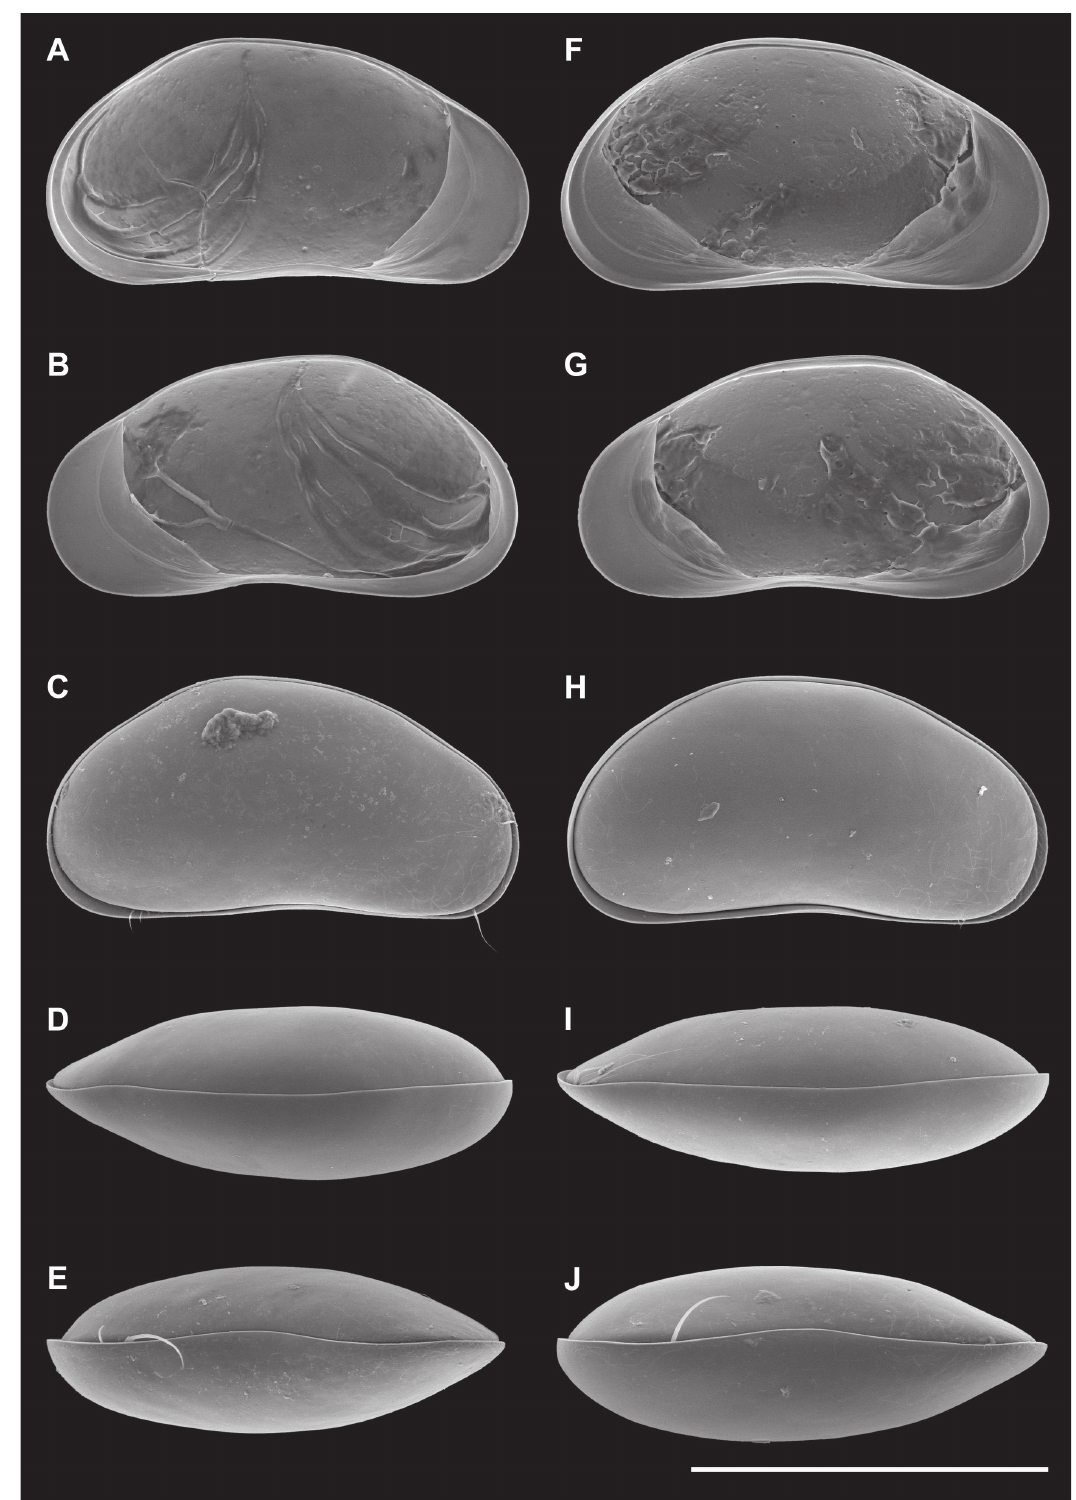
Fig. 2. Valves of Pseudocandona agostinhoi sp. nov. A–E ♂ and F–J ♀. A, F . LV, internal view (A = MZUSP 32655, F = OC. 3303). B, G . RV, internal view (B = MZUSP 32655, G = OC. 3303). C, H . Cp, right lateral view (C = MZUSP 32660, H = MZUSP 32667). D, I . Cp, dorsal view (D =MZUSP 32661, I = MZUSP 32668). E, J . Cp, ventral view (E = OC. 3304, J = OC. 3305). Scale bars: A–J = 500 µ